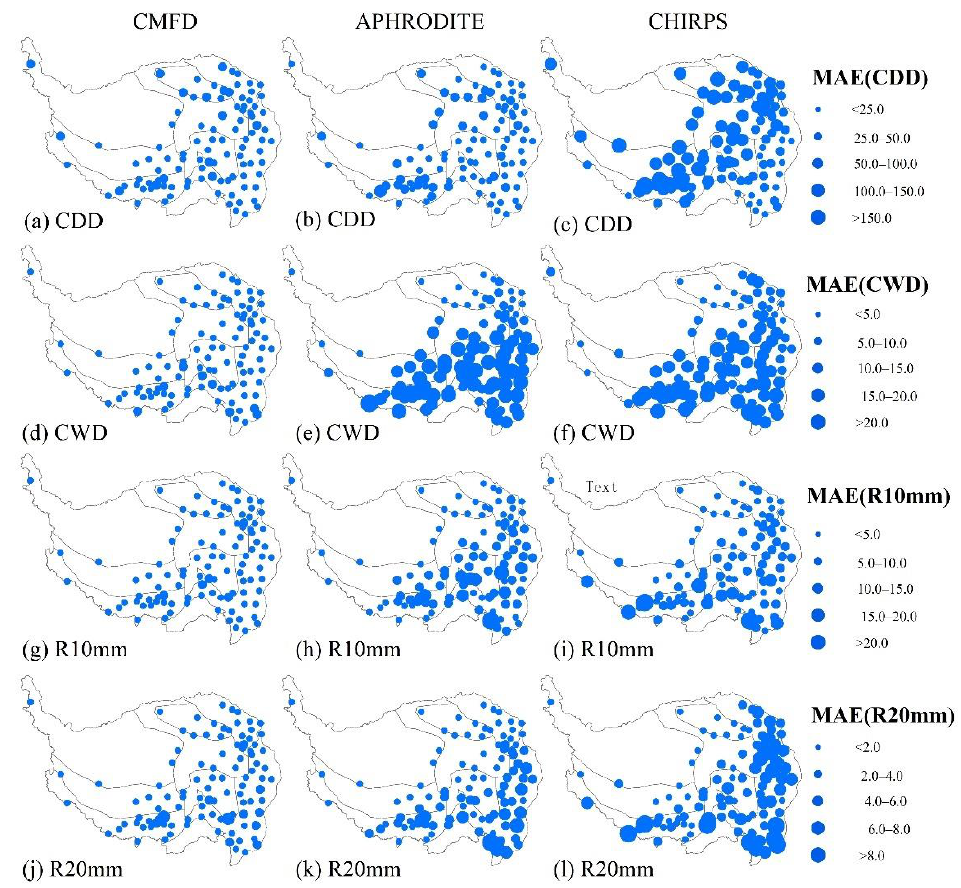
Figure 7. MAE for gauge-based fixed threshold indices CDD, CWD, R10mm, and R20mm, as derived from CMFD, APHRODITE, and CHIRPS for the period 1981 – 2014.